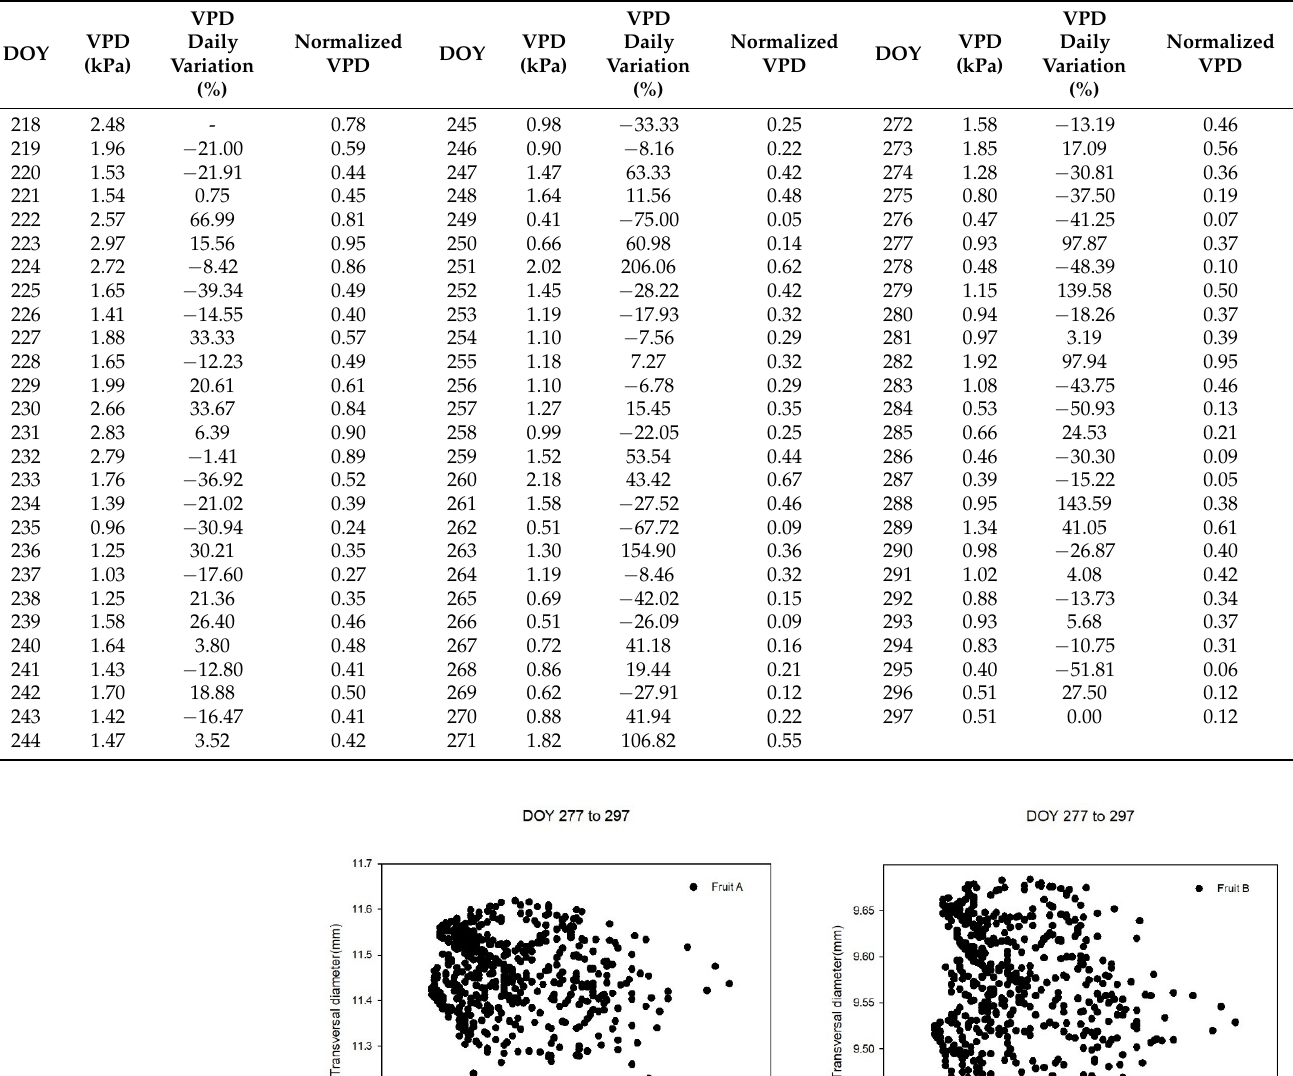
Table 1. VPD raw data. DOY 218 was beginning of experiment. So, the percentage of changing VPD in comparison with the same measured the day before (VPD daily variation) was exclude from table.